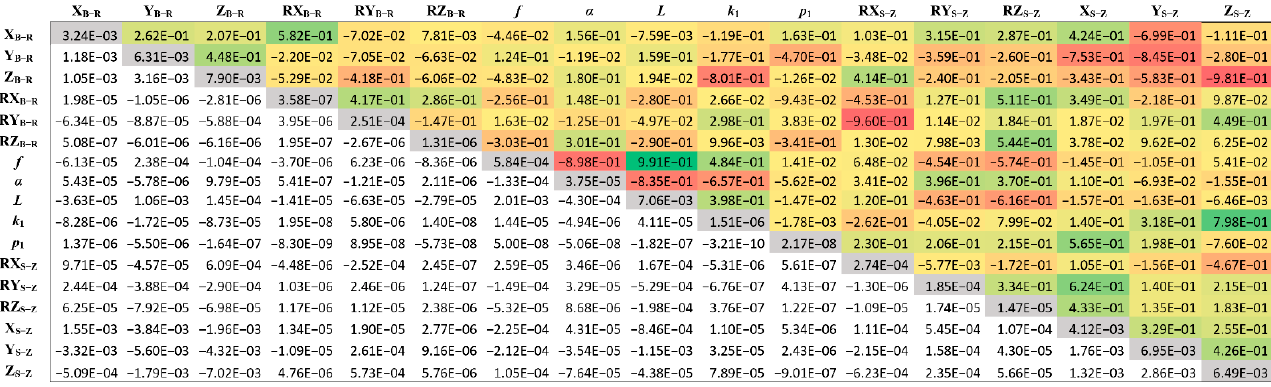
Figure 12. Correlation and covariance matrices. The upper triangle shows correlations and the bottom covariances. Diagonal values (gray color) are variances. Red and green colors present highly correlated parameters.